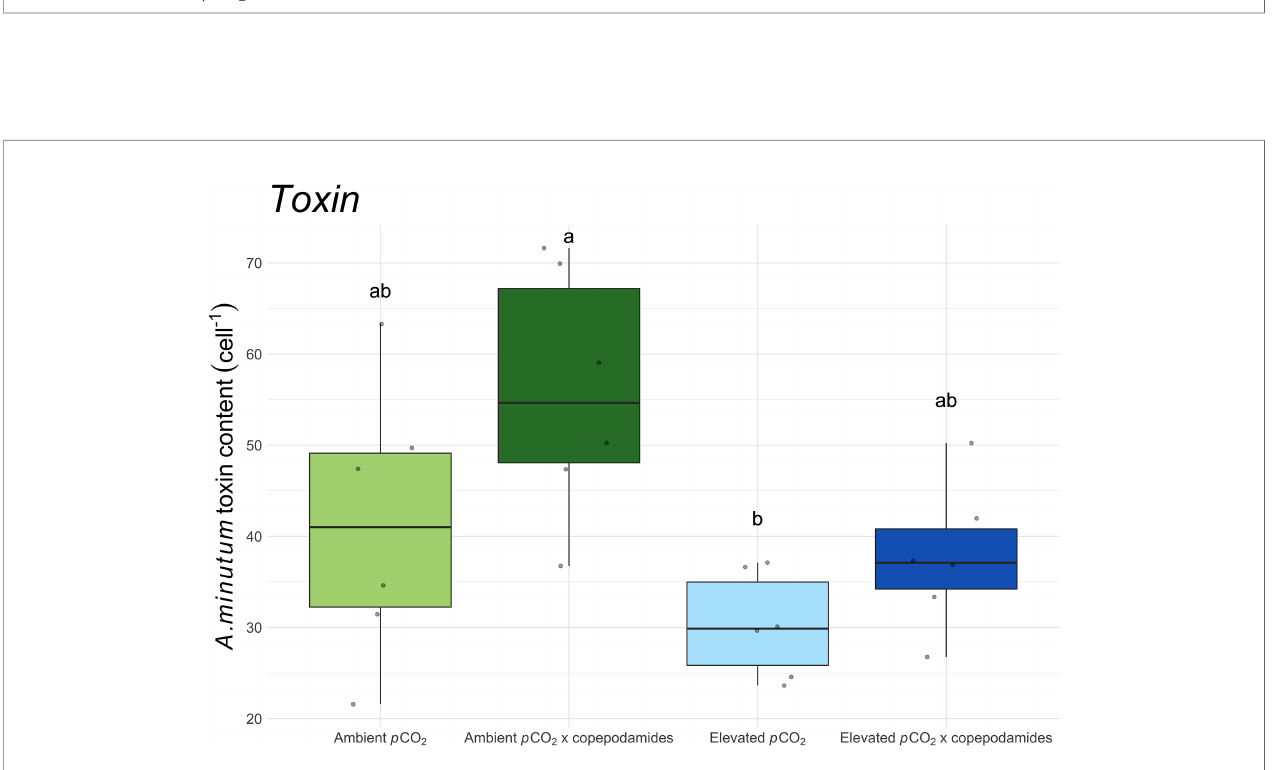
FIGURE 4 | Box plot of Alexandrium minutum toxin content (cell -1 ) after 48 hours exposure to one of four treatments ( “ ambient p CO 2 ” , “ ambient p CO 2 x copepodamide ” , “ elevated p CO 2 ” or “ elevated p CO 2 x copepodamide ” ). Solid line inside the box signi fi es the median, box contains the lower and upper quartile ranges, and dots represent individual observations; letters denote signi fi cance ( p < 0.05), n =